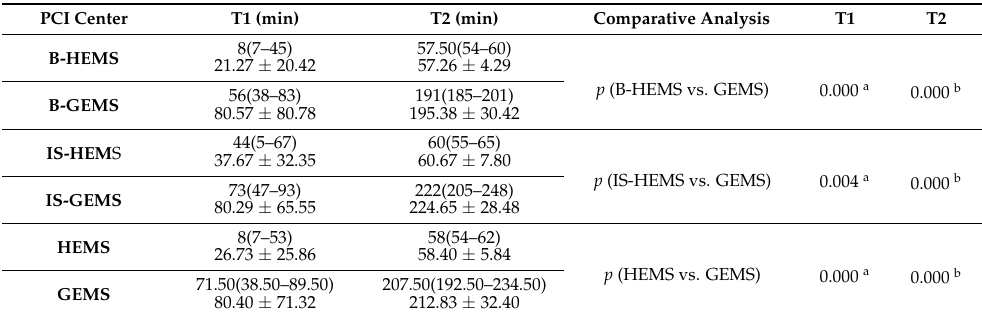
Table 2. Comparative analysis of the GEMS and HEMS transfer times of STEMI patients to Bucharest and Iasi PCI centers.